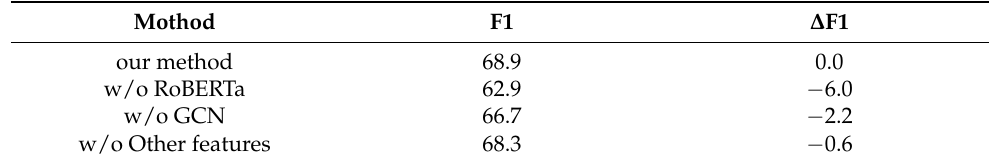
Table 2. Experimental results of the ablation